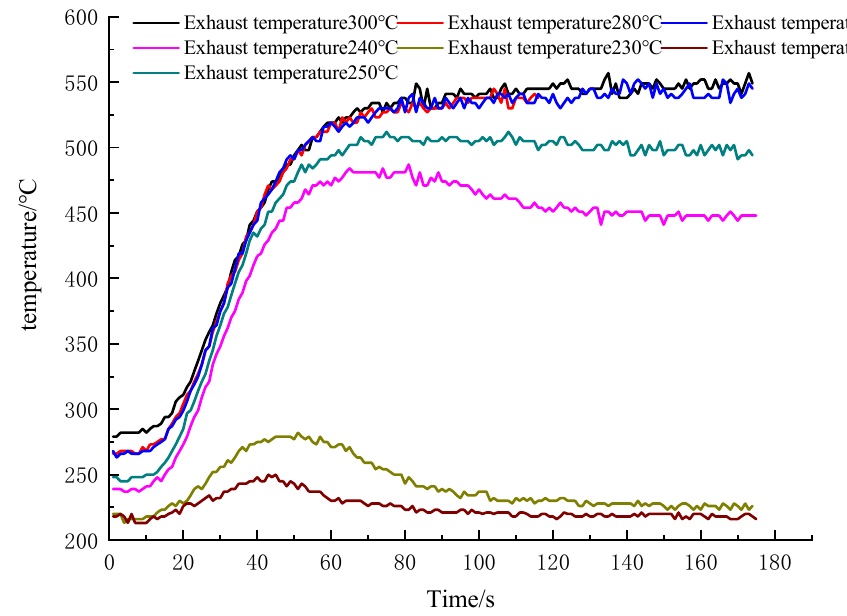
Figure 3. Variations in pre-DPF temperature (T2) at different DOC inlet temperatures.